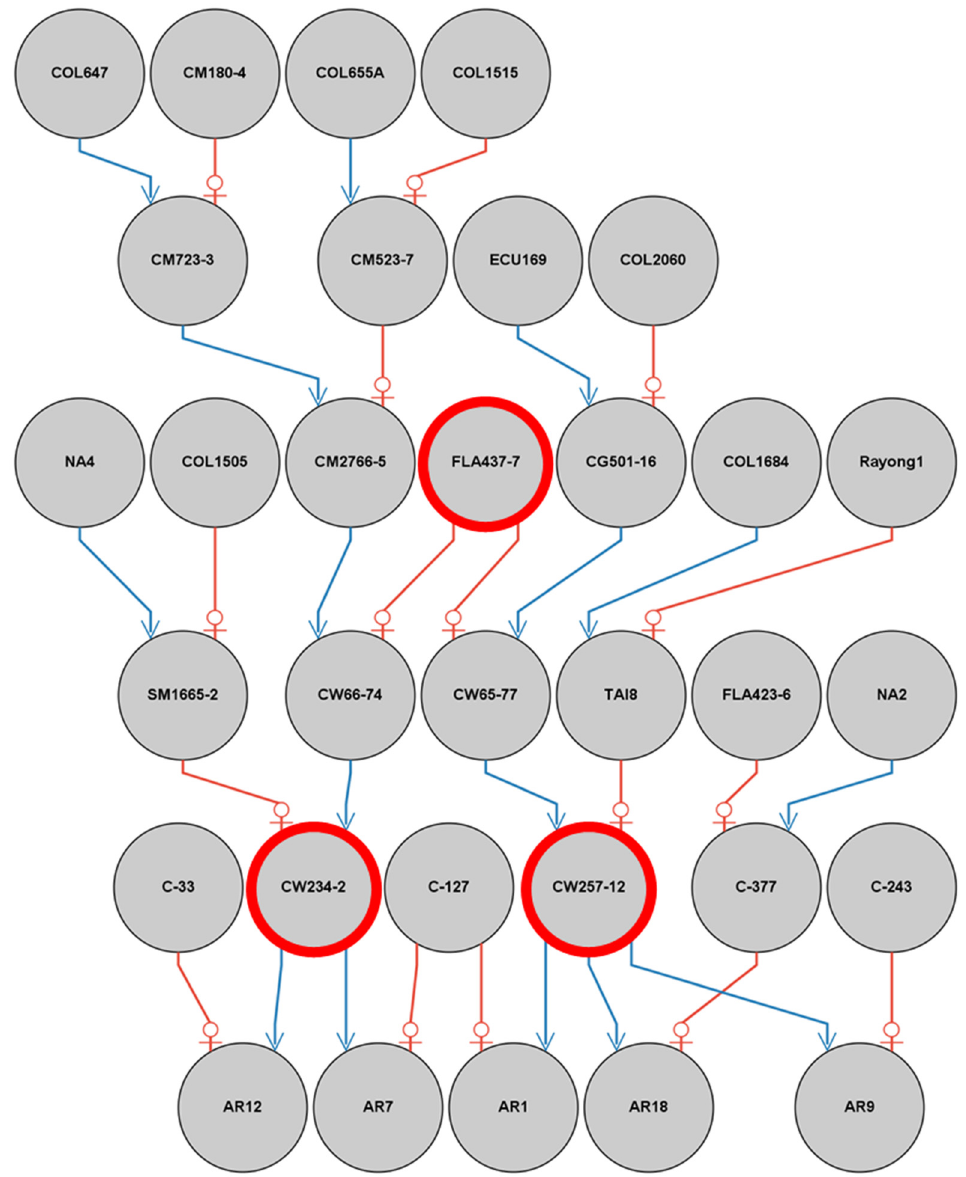
Figure 3. The pedigree of the five full-sib families, AR1, AR7, AR9, AR12, and AR18, which might have the T allele of S12_7926132 without CMD resistance. Families AR7 and AR12 shared the progenitor CW234-2, and families AR1, AR9, and AR18 shared the progenitor CW257-12. CW234-2 and CW257-12 might be the sources of the T allele without CMD resistance. Both progenitors were derived from the wild crosses with FLA437-7 ( M. esculenta ssp. flabellifolia ). For the other CMD marker on chromosome 14, S14_4626854, among 35 clones with the resistant allele A, 29 clones did not have any CMD symptom, and significant differences were observed between genotype A:G and G:G (t (79) = − 7.23, p < 0.01; Figure 4a). The progeny of C-4 and C-127 did not have the resistant allele A and showed high CMD scores (Figure 4b). Similar with marker S12_7926132, the progeny of CW234-2 and CW257-12 showed variation in CMD scores even though they had the resistant allele A (Figure 4c).